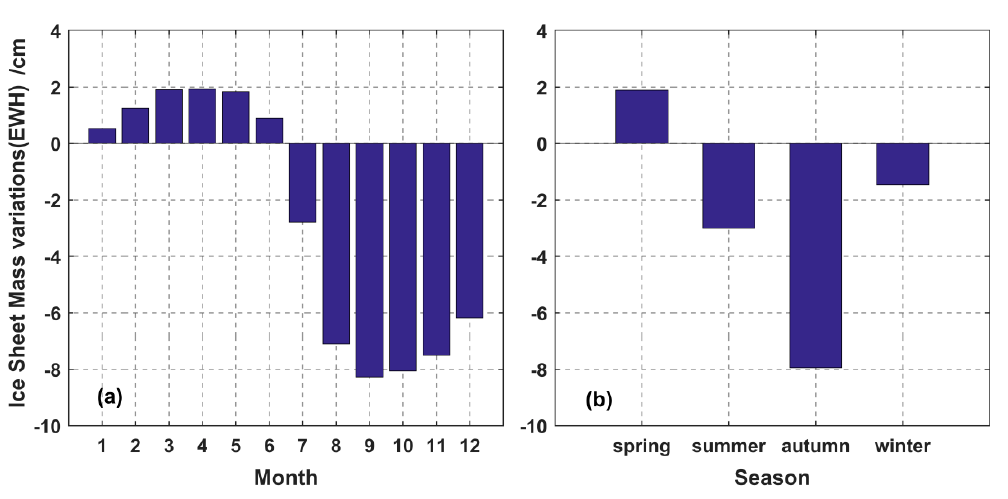
Figure 3. ( a ) and ( b ) represented monthly and seasonal changes in the mass of the Greenland ice sheet from January 2003 to December 2015,